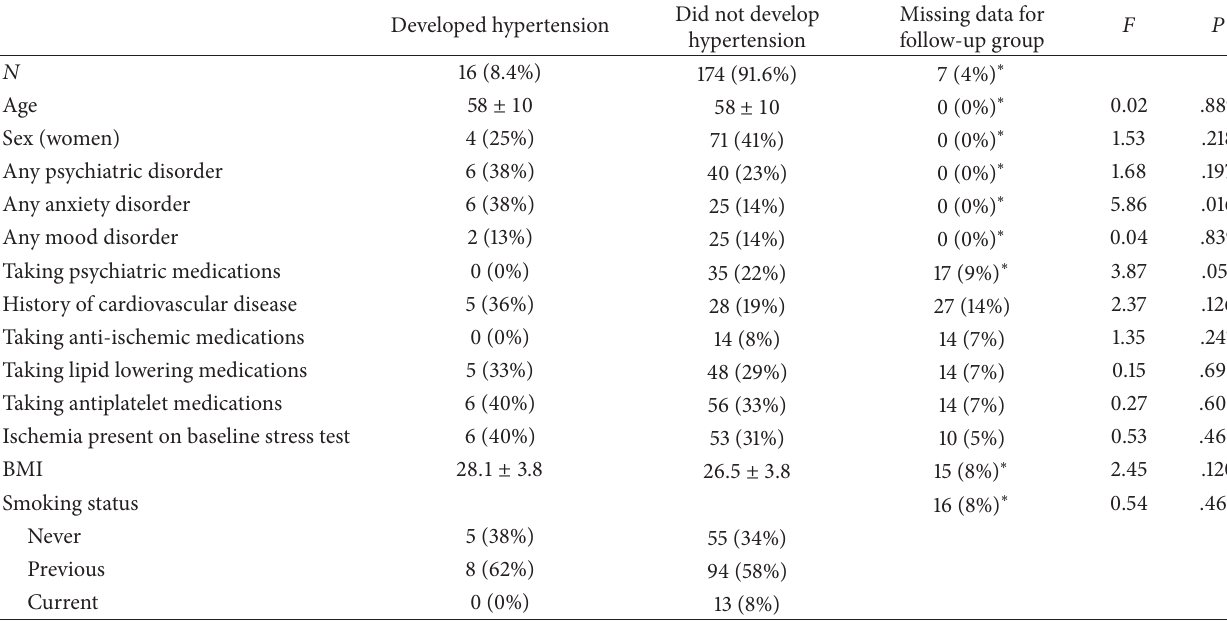
Table 1: Comparison of baseline characteristics in nonhypertensive patients who did and who did not develop hypertension at follow-up